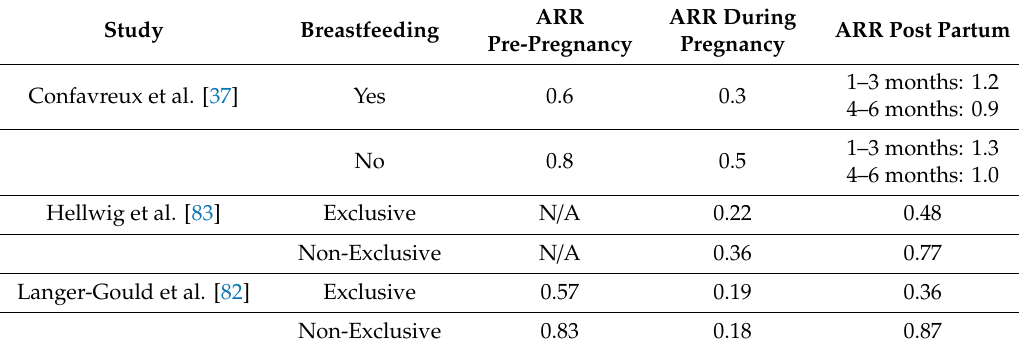
Table 5. Annualized relapse rates (ARR) in